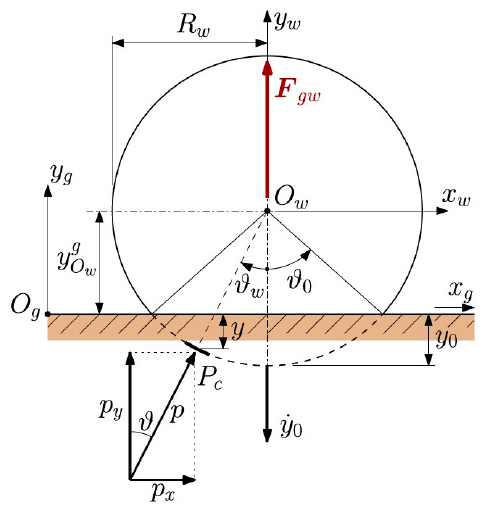
Figure 18. Illustration of the contact between the rear wheel and the ground.